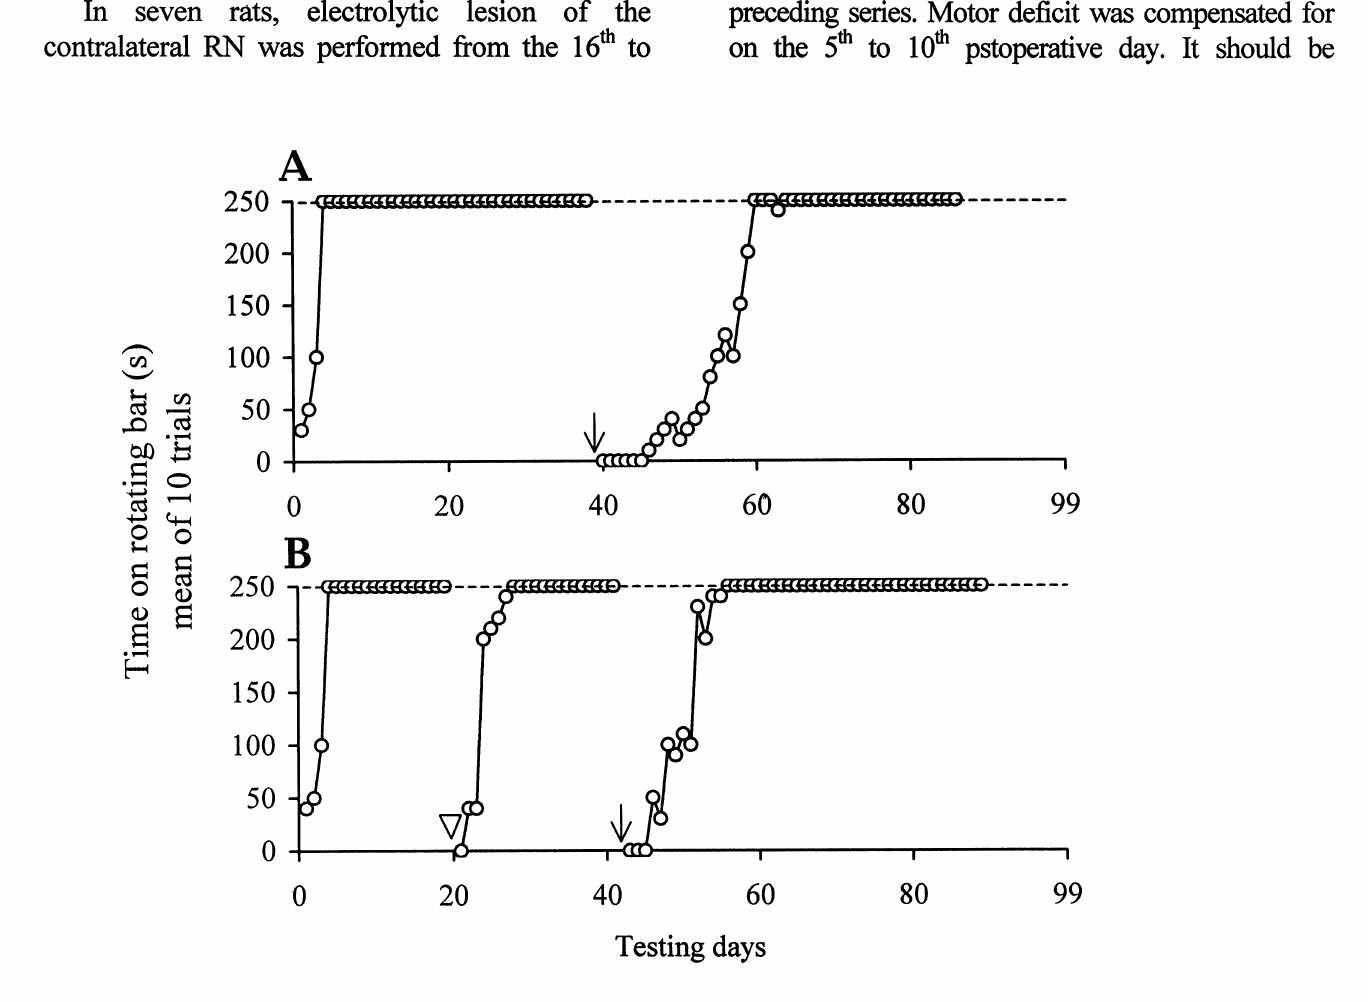
Fig. 2: Effects of transection of the dorsolateral funiculus and electrolytic lesion of the RN on the performance of learned insmmaental reflexes in two rats. (A) RN alone was lesioned. (B) RN lesion was made alter transection of the DLF. The progression of the reflexes is shown in days (abscissa). The mean value (in seconds) of 10 trials on the rotating bar is plotted for each training day (ordinate). The dashed line is the 250-s criterion level of performance. The open arrowhead designates the day ofthe DLF transection; the arrow indicates the day of RN